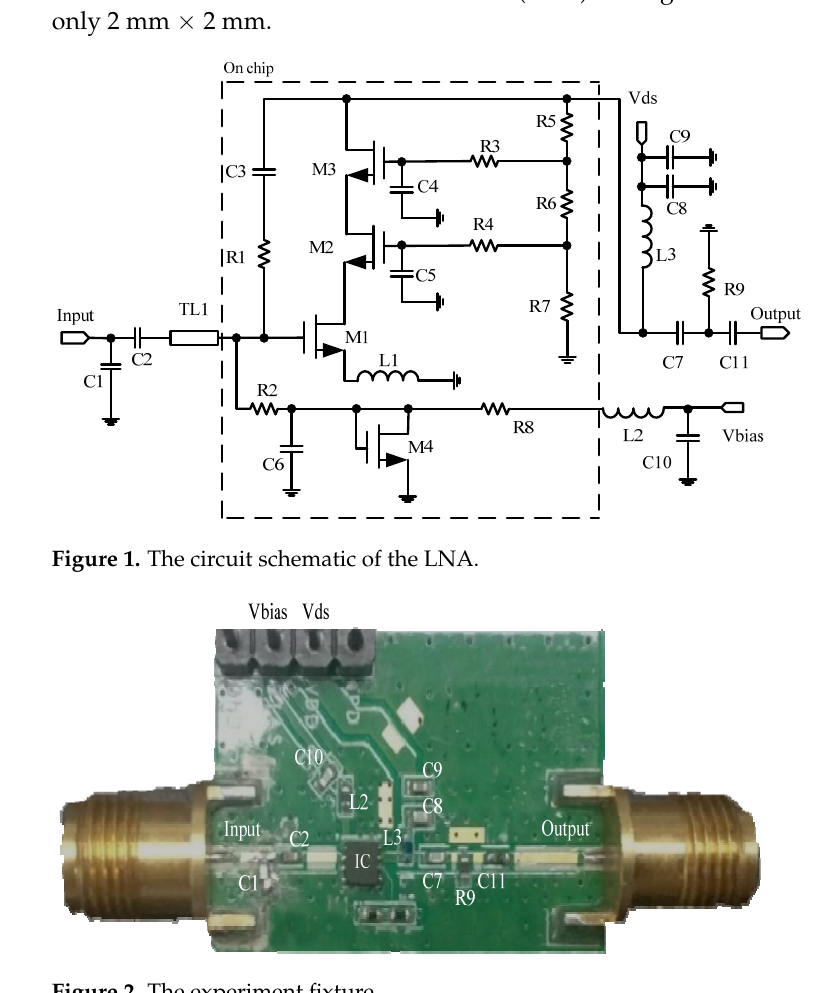
Figure 2. The experiment fixture.